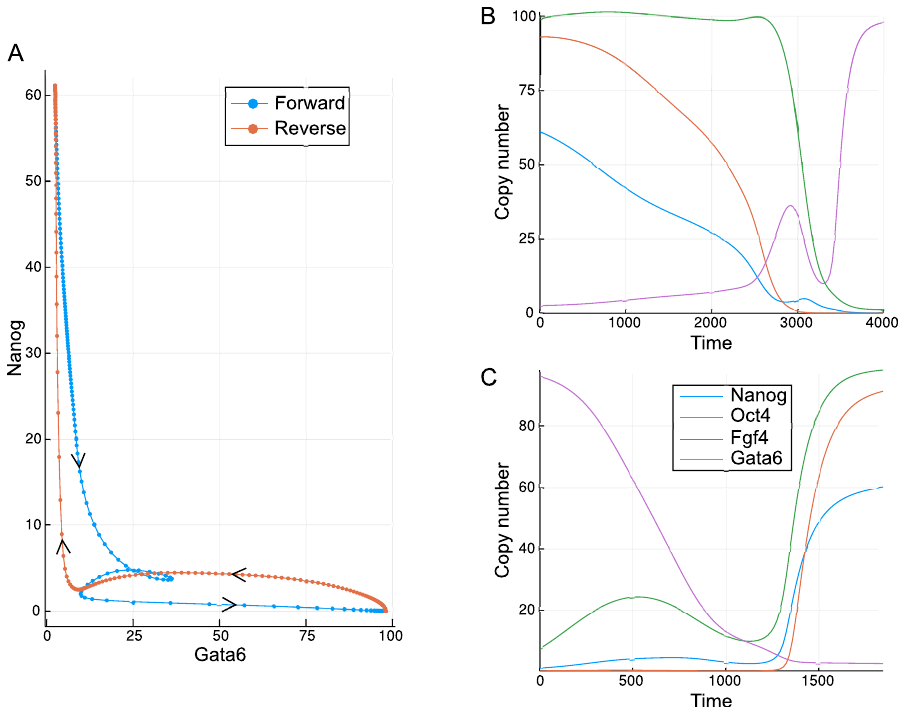
Fig 6. Minimum action paths for the developmental model. (A) A comparison of the paths plotted in the Gata6, Nanog plane; (B) Time series for each of the molecular species in the forward direction; (C) Time series for each of the molecular species in the reverse